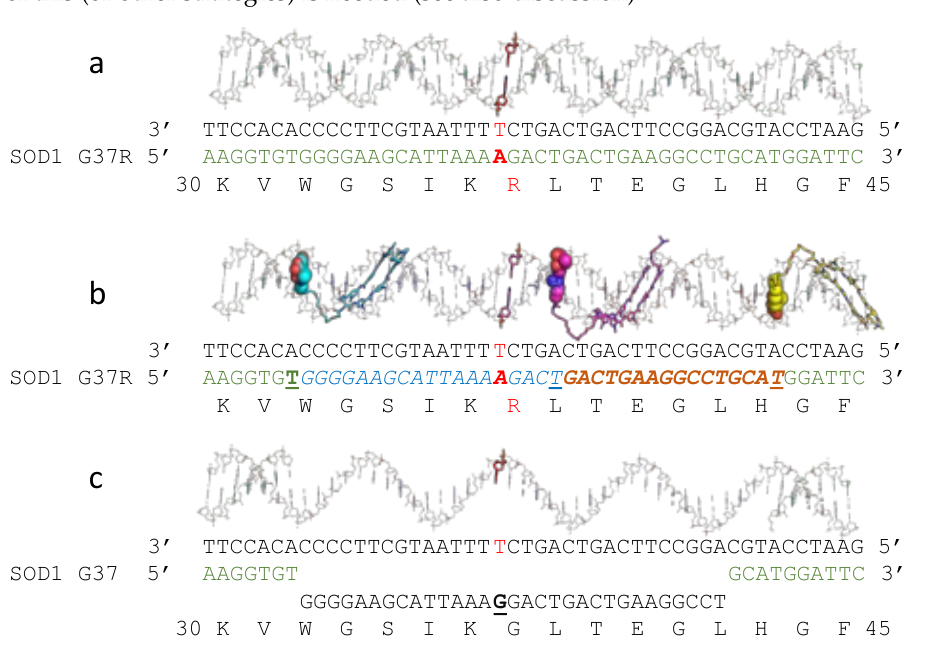
Figure 7. Modelling a theoretical correction by three camptothecin based PIP-OTIs of a mutation associated with familial ALS. ( a ) A model (BDNA, 8 June 2022, from http://www.scfbio-iitd.res.in/software/drugdesign/bdna.jsp) of nucleotides (one strand carbons in black, the other in green) coding amino acids 30–45 (single letter code bottom line) of human SOD1 with a G37R mutation. The single base-pair change causing the glycine to arginine mutation is highlighted in red. ( b ) Three camptothecin based PIP-OTIs are shown coloured with cyan, magenta and yellow carbons, with the intercalating camptothecin moiety in solid space-fill representation. Three positions (TG) cut on the lower strand, in the presence of Top1 (see also Supplementary Figures S3 and S5) are indicated. In cleavage complexes the T is covalently bonded to Top1 by a 3′ phosphotyrosine bond and the camptothecin moiety intercalates between the TA and GC base-pairs at the DNA-cleavage site. ( c ) The blue and orange oligonucleotides in b are envisioned to have been removed – and are replaced with an oligonuleotide with a corrected G. The T in the central G-T mismatch should be removed by thymine DNA-deglycoylase–after which the red T in the top strand should be corrected to C.